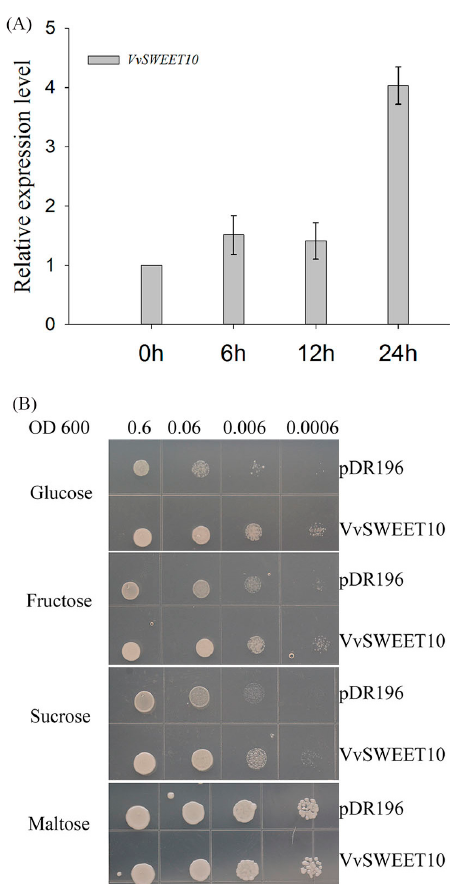
Figure 4. Functional characterization of VvSWEET10 . ( A ) Low sugar supply stimulates the expression of VvSWEET10 in grape berry suspension cells. Berry suspension cells were cultured in a sugar-free medium for a starvation condition, and the transcript levels of VvSWEET10 were analyzed within 24 h. ( B ) Complementation of yeast EBY.VW4000 with VvSWEET10 ; drop tests were used to observe the cell growth on SD (-Ura) media supplemented with 2% maltose, 2% sucrose, 2% fructose or 2% glucose. Cells were grown at 30 °C for 3 days.